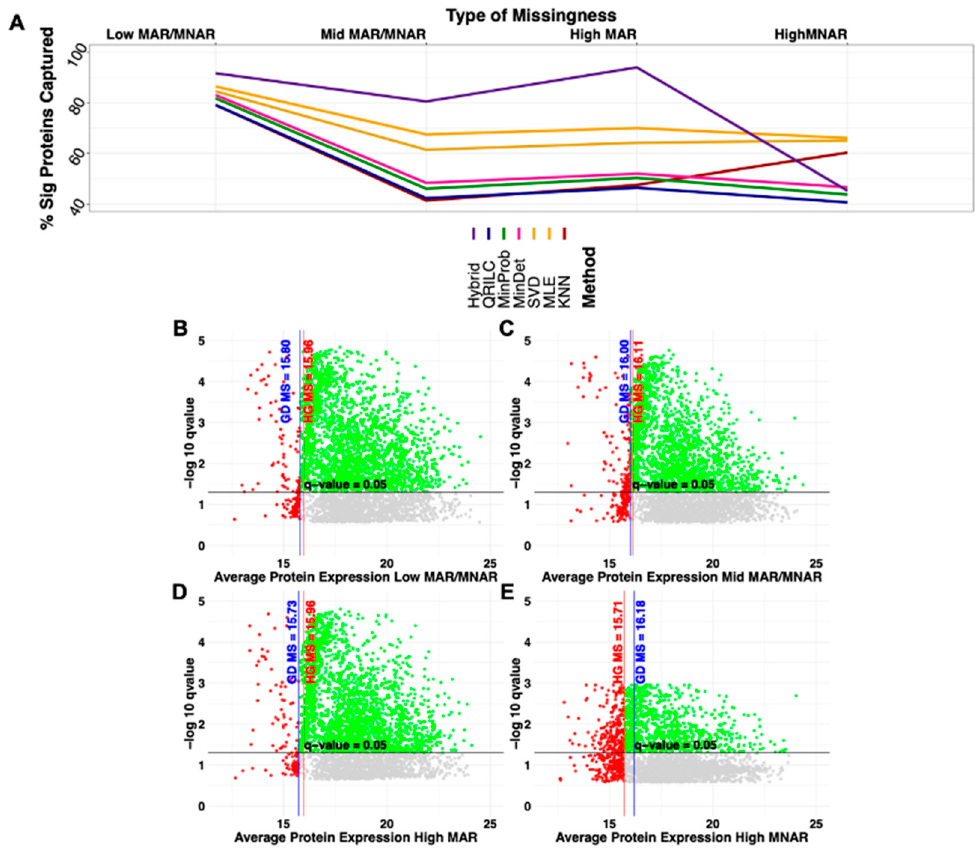
Figure 1. Summary of imputation method performance with increasing missingness (amputation type) in simulated data and protein expression profiles in hybrid. ( A ) The percentage of significant proteins remaining from the original simulated data as missingness increased for each of the imputation methods. ( B – E ) Significance versus protein expression for each of the amputed datasets following the hybrid imputation method. Proteins in green represent significant proteins with expression or imputed expression above the lowest (leftmost) MNAR model selector value, while non-significant above the MNAR model selector value are in gray. Those in red are imputed below the lowest MNAR model selector value and are significant above the black line ( q -value < 0.05) and not significant below the black line.